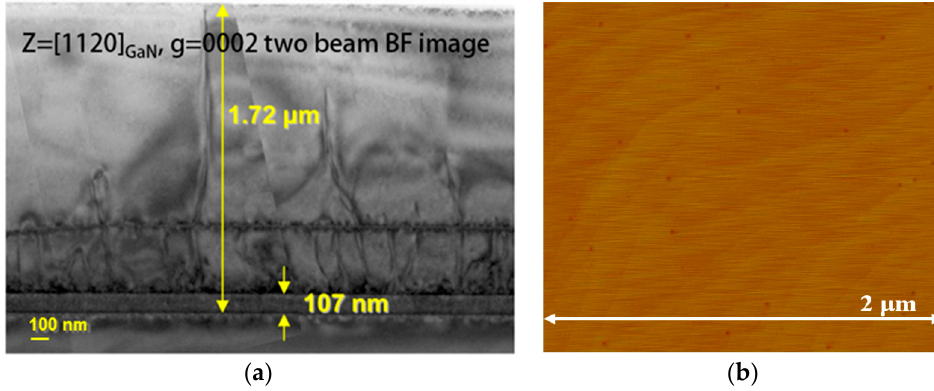
Figure 6. ( a ) TEM and ( b ) AFM images of GaN grown on Si substrate with the two-step growth method.